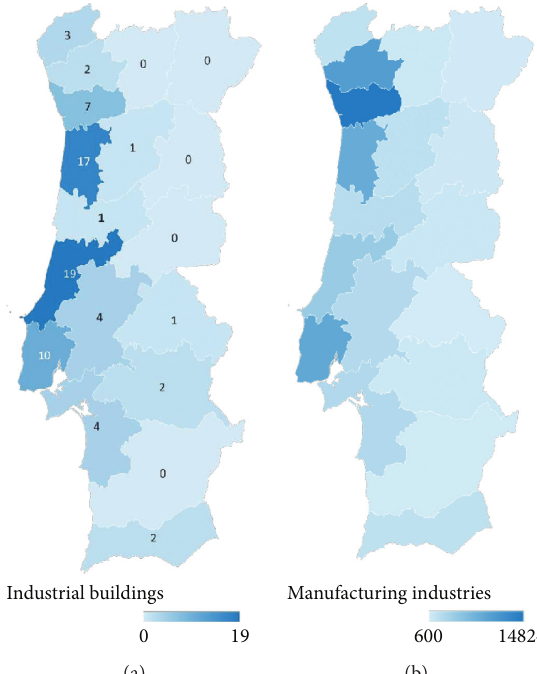
Figure 6: Location of industrial buildings in Portugal: (a) collected projects and (b) manufacturing industries in